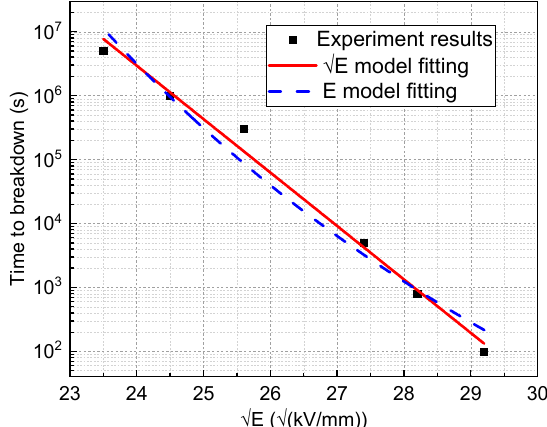
Figure 14. TDDB results and two different fitting models [95].